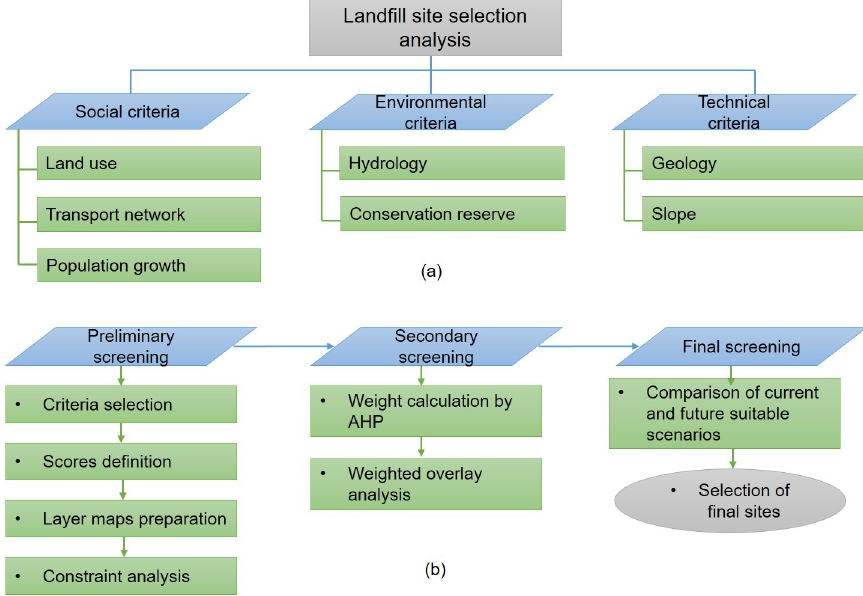
Fig 3. Criteria and methodology. (a) site selection criteria; (b) steps for assessing landfill site